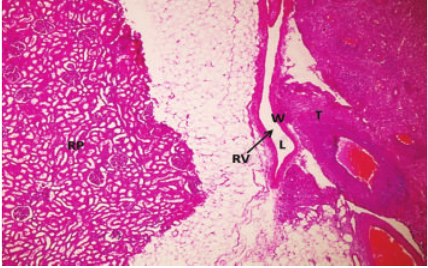
Figure 3: The relationship between tumoural tissue and renal vein (T: tumor, RV: renal vein, L: lumen, W: wall, and RP: renal paren- chym; H&E × 40).